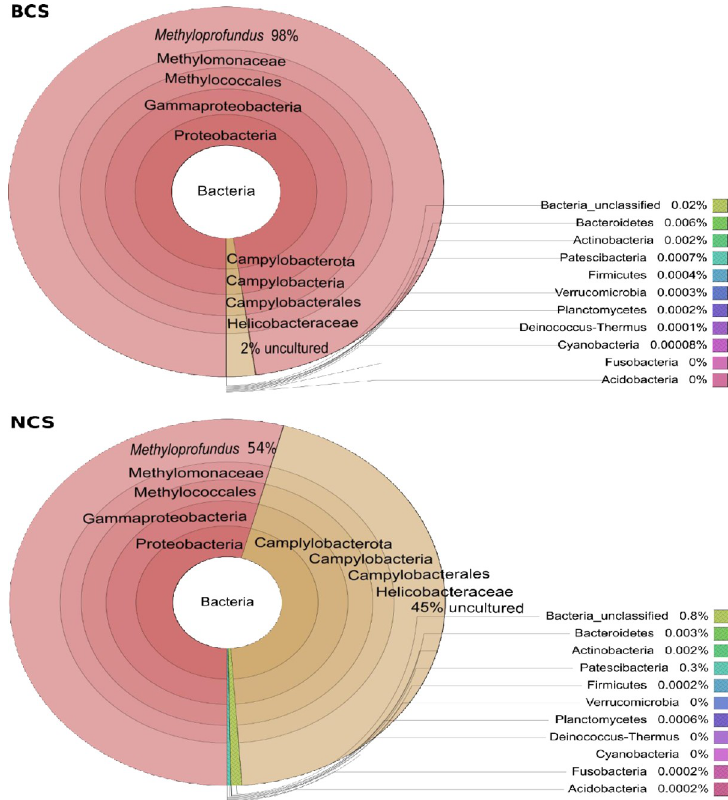
Fig 7. Hierarchical distribution of bacterial diversity at each site. The top circle represents Baltimore Canyon site (BCS) and the bottom circle represents Norfolk Canyon site (NCS). The taxonomic hierarchy proceeds outward. Primer set 1 (ps1) is shown. The results from ps2 and ps4 were similar, but ps3 lacked Campylobacterota due to substantial primer mismatches.